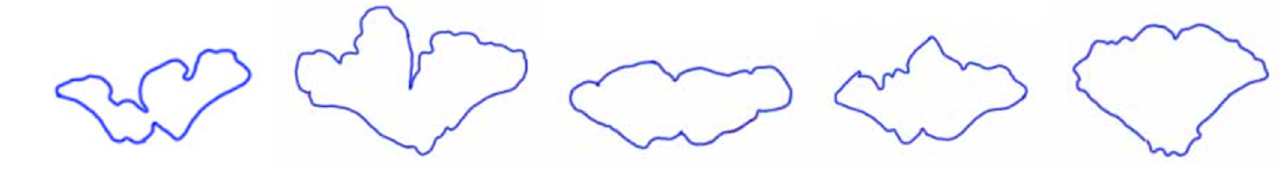
Figure 2. Example of a composite assemblage of all frontal sinus slices ( n = 15) traced in red with outermost limit in blue. Note that the red lines extending from the inferior border represent the sinus’s transition into the nasal cavity.